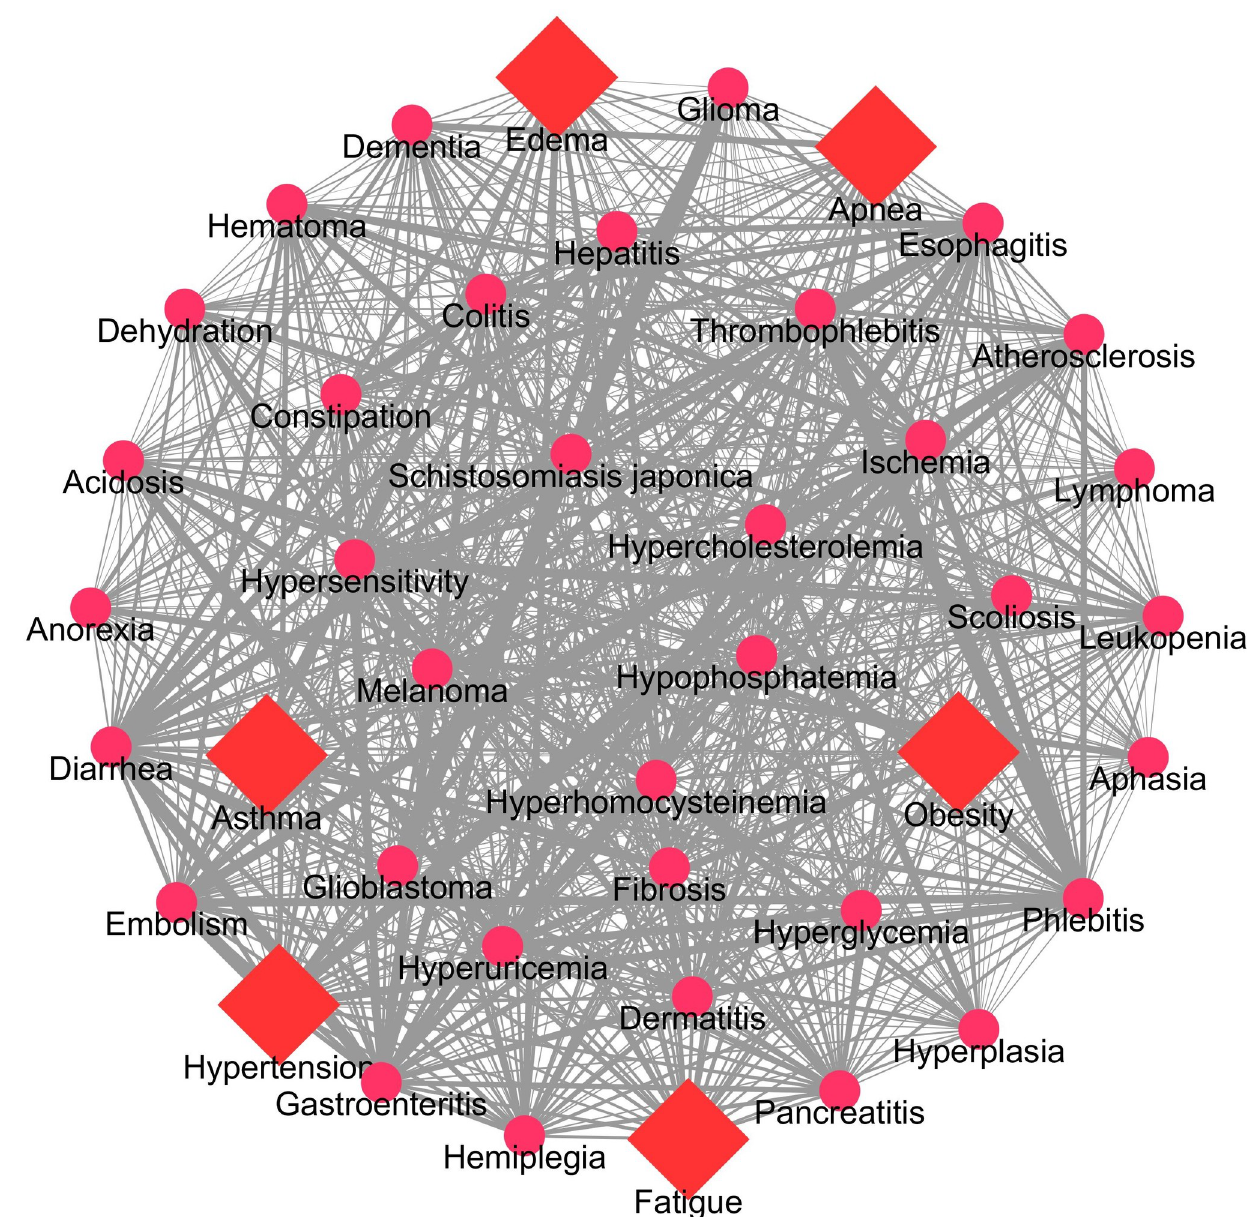
Fig 4. Disease ontology (DO) based semantic similarity disease network (DSN) of high altitude. The disease (red colour square shape) pairs showing the > 90 percentile (outliers) literature frequency were used in the construction. The average degree (number of links with other diseases) of all diseases in the disease network is 0.1418 (marked as gray lines). The edge thickness represents the SS score between two diseases. Note that the bottleneck diseases of high altitude in the network are in square shapes rather than circle otherwise.